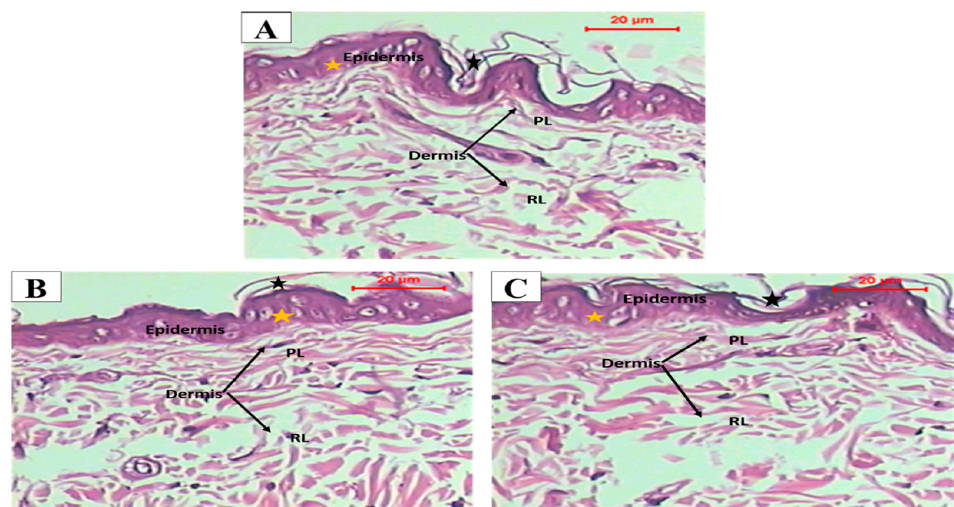
Figure 6. Photomicrographs showing the histopathological sections of ( A ) normal untreated rat skin, ( B ) rat skin treated with OLM optimized oleogel formulation, and ( C ) rat skin treated with lavender oil with magnification power of × 200 to illustrate the epidermis and dermis layers. Abbreviations: PL, papillary layer and RL, deeper reticular dermal layer.